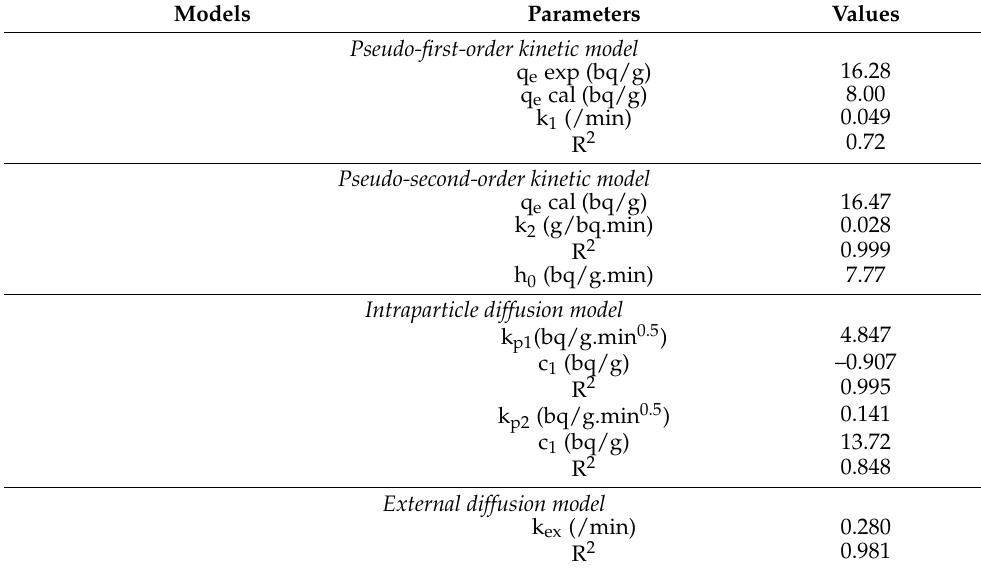
Table 3. Kinetic parameters for Radium adsorption on WTBS.